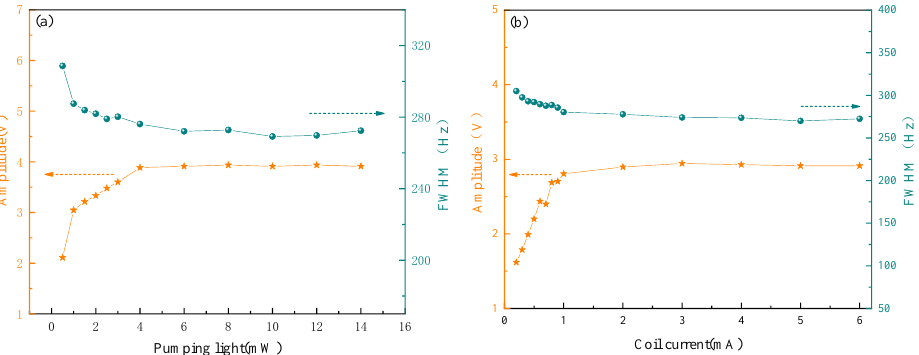
Figure 5. ( a ) Dependence of signal amplitude and FWHM on pump power—coil current that gener- ated RF magnetic field was 4 mA; ( b ) Dependence of signal amplitude and FWHM on RF magnetic field—pump power was 15 mW. For ( a , b ), the conditions for other parameters were as follows: probe power was 100 µ W, and frequency was red detuned to 45 GHz relative to 5 S 1/2 ( F g = 3)–5 P 1/2 ( F g = 2) transition of 85 Rb atoms. Pump beam was resonant with the 5 S 1/2 ( F g = 3)–5 P 1/2 ( F g = 2) transition of 85 Rb